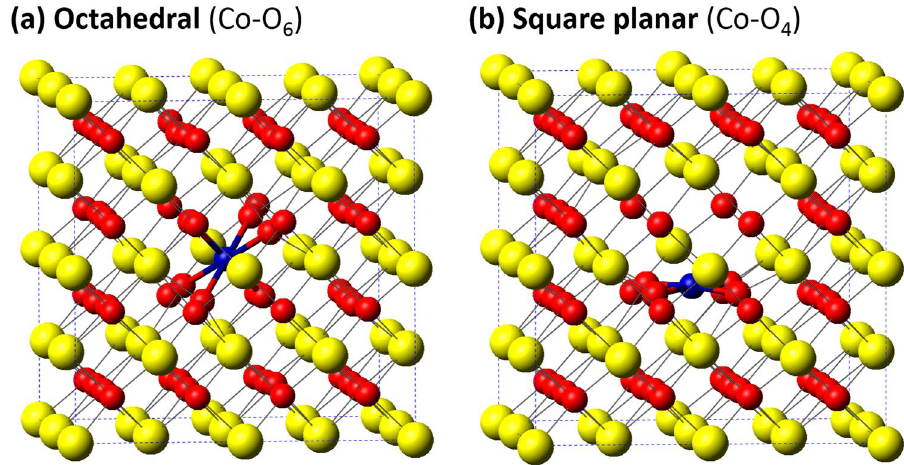
Figure 5. Schematic view of Co doped CeO 2 with different Co dopant coordination geometry: ( a ) octahedral coordination ( b ) square-planar coordination. The yellow balls, red balls, and blue balls represent the Ce, O, and Co atoms, respectively.